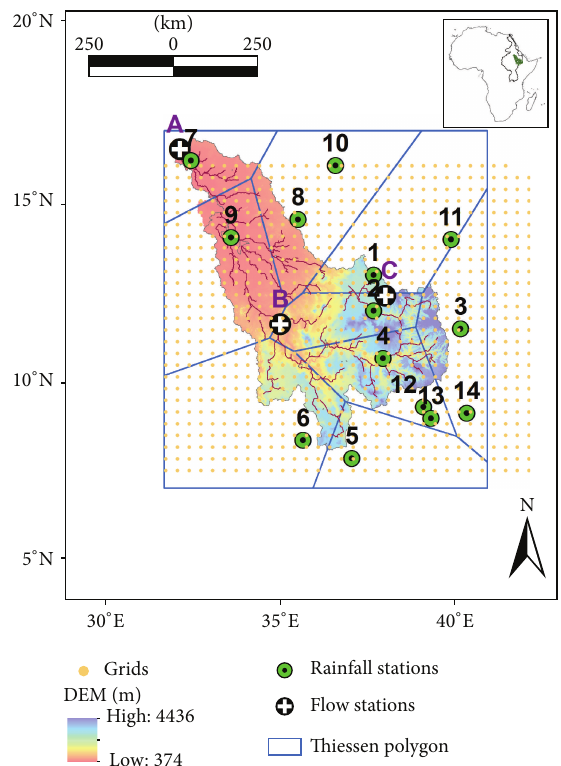
Figure 1: Location of the BNB. The labels of the flow and rainfall stations are consistent with those in Table 1. The Digital Elevation Model (DEM) used as the background map was obtained online from the International Centre for Tropical Agriculture, CIAT-CSI SRTM website, http://srtm.csi.cgiar.org/ (accessed: 20th October,